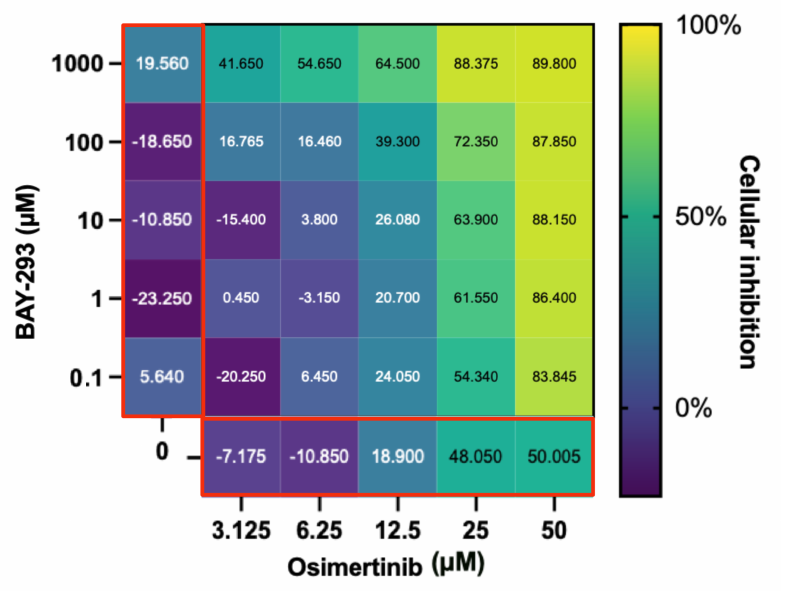
Figure 6. Evaluation of the BAY-293 and osimertinib drug combination. The main heatmap panel outlined in black shows H1792 inhibition as a percentage normalized using untreated controls ranging from 0% (dark blue) to 100% (yellow) for different concentrations. BAY-293 and osimertinib by themselves are on the left and bottom, respectively, (both outlined in red). This shows that although H1792 did not respond strongly to BAY-293 alone, a synergistic effect on cellular inhibition was observed when combined with osimertinib. Created with